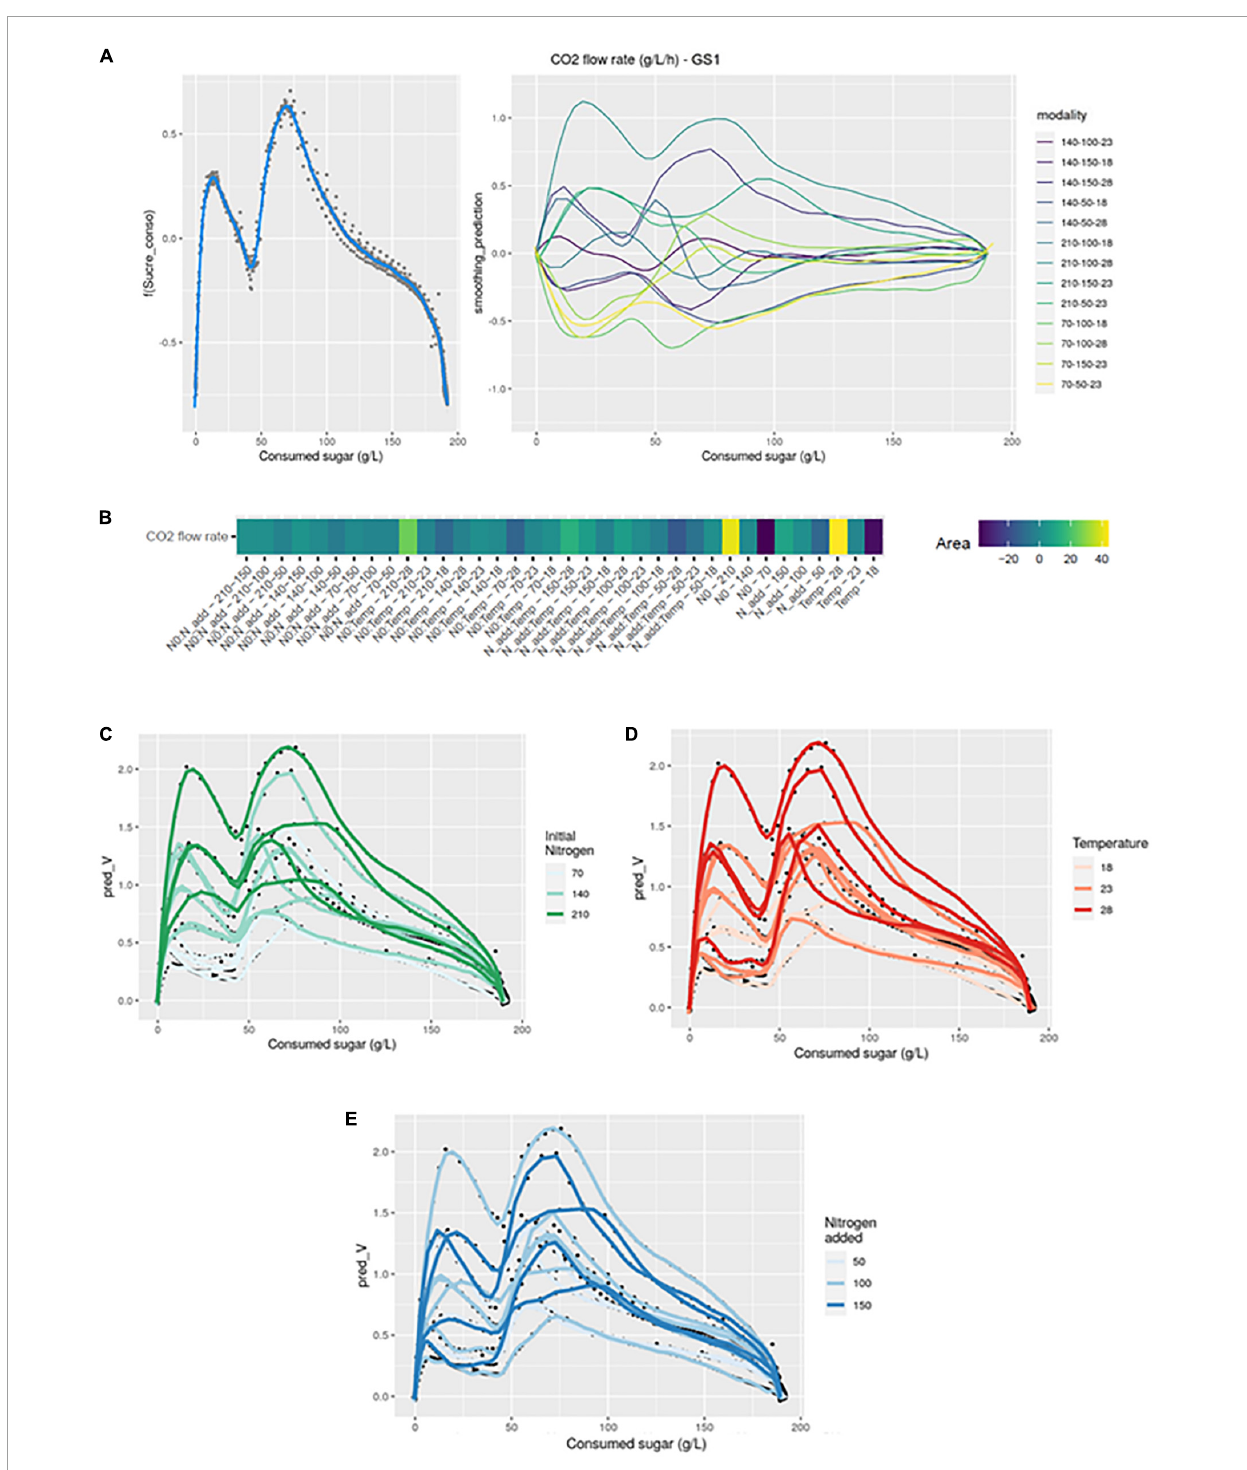
FIGURE1 GAM modeling of fermentation kinetics. (A) Left: Smoothing average of the fermentation rate, right: Deviations of each modality from this average smoothing. (B) Heatmap representing magnitudes of each factor and every possible interaction using areas under the curves of the deviations from the average smoothing. (C–E) Prediction curves for each modality represented with a color depending on the level of NO, temperature and Nadd.